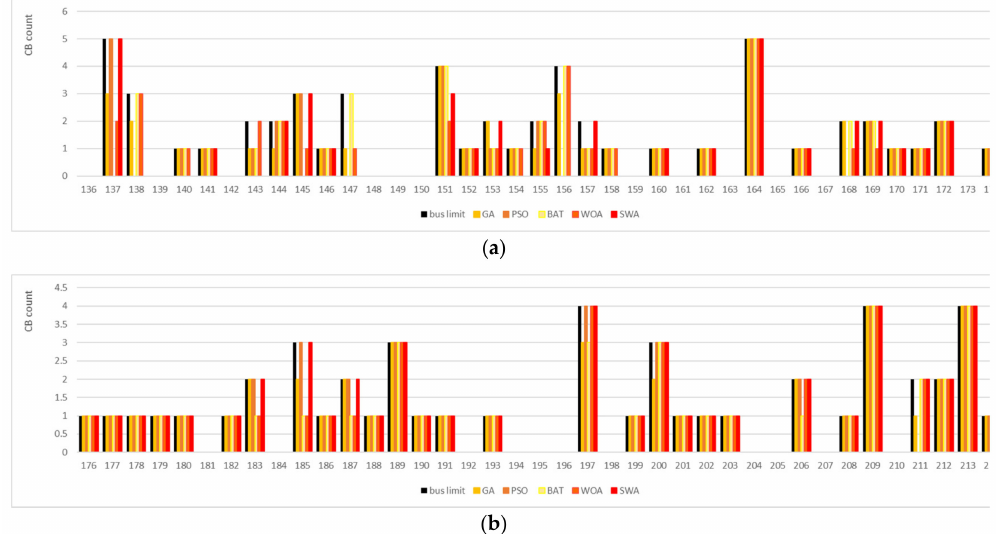
Figure 22. The number of CBs allocated in the buses of the 215-bus network by each algorithm: ( a )—buses 136-175, ( b )—buses